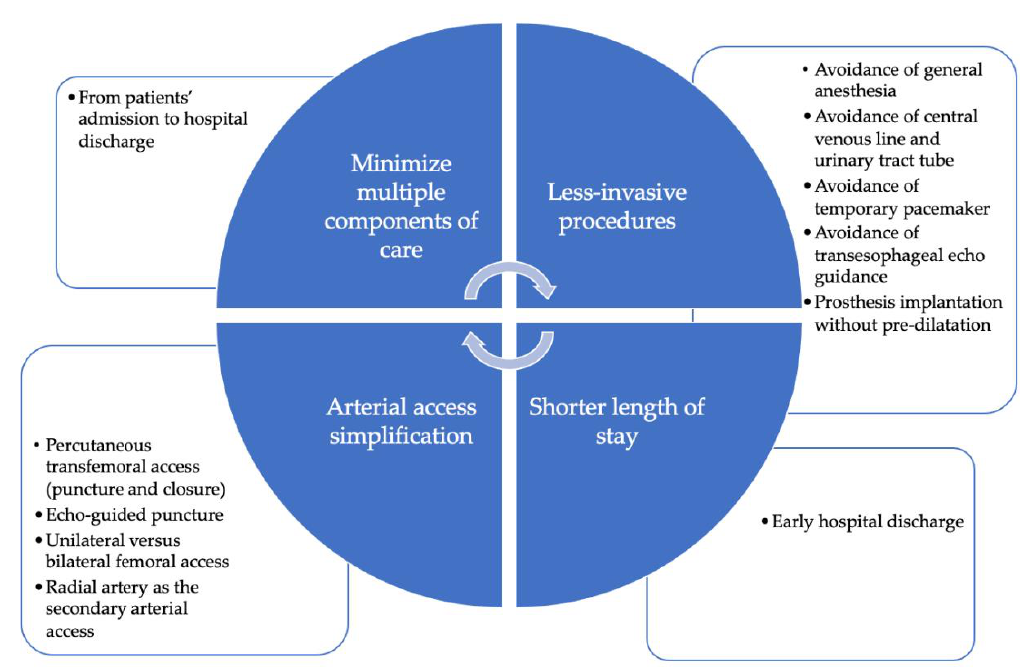
Figure 1. The main steps of a minimalist TAVI approach.